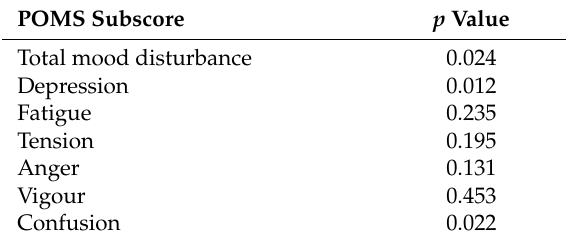
Figure 1. Relationship between total mood disturbance (TMD) score and plasma vitamin C concentration. ( A ) Participants were divided around the mean plasma vitamin C concentration of 58.2 µmol/L. ( B ) Participants were divided around adequacy of vitamin C status (a plasma concentration of 50 µmol/L indicates adequacy). Box plots show median TMD score with the 25th and 75th percentiles as boundaries; whiskers indicate the minimum and maximum of all the data. The TMD score was significantly different between the two groups for each graph (Mann–Whitney U test on ranks). Table 3. Association of plasma vitamin C adequacy with Profile of Mood States (POMS) mood subscales.